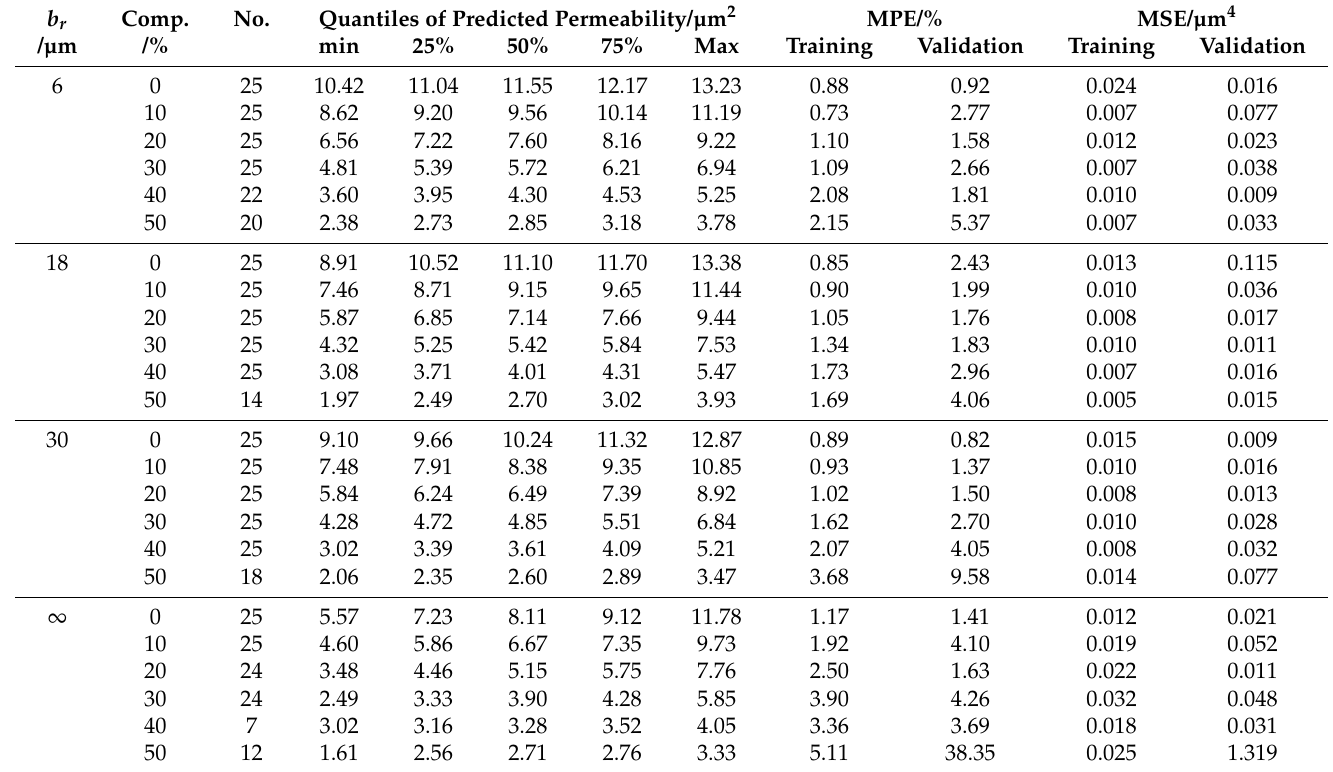
Table 2. Predicted permeability, mean percentage error MPE, and mean squared error MSE on subsets of training and validation data of Fold No.